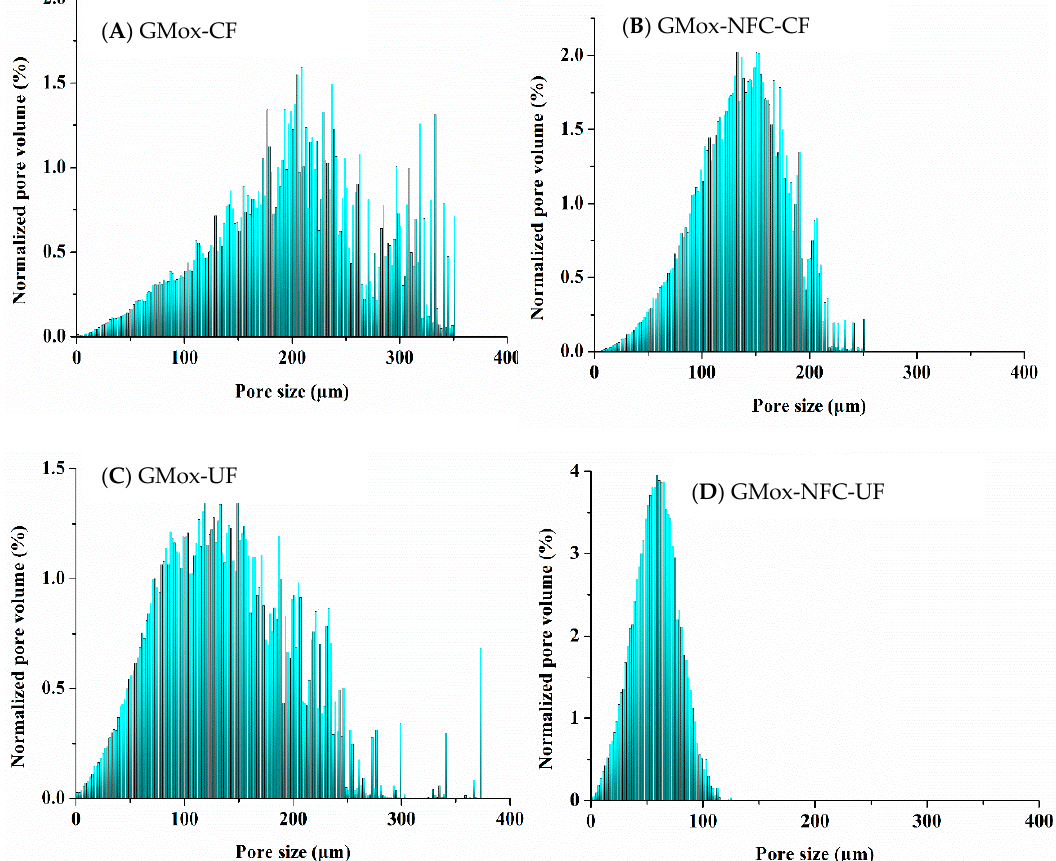
Figure 7. Volume-weighted pore-size distribution of ( A ) GMox and ( B ) GMox reinforced with NFC using the conventional freezing (CF) method. Volume-weighted pore-size distribution of ( C ) GMox and ( D ) GMox reinforced with NFC prepared by the unidirectional freezing (UF) method.